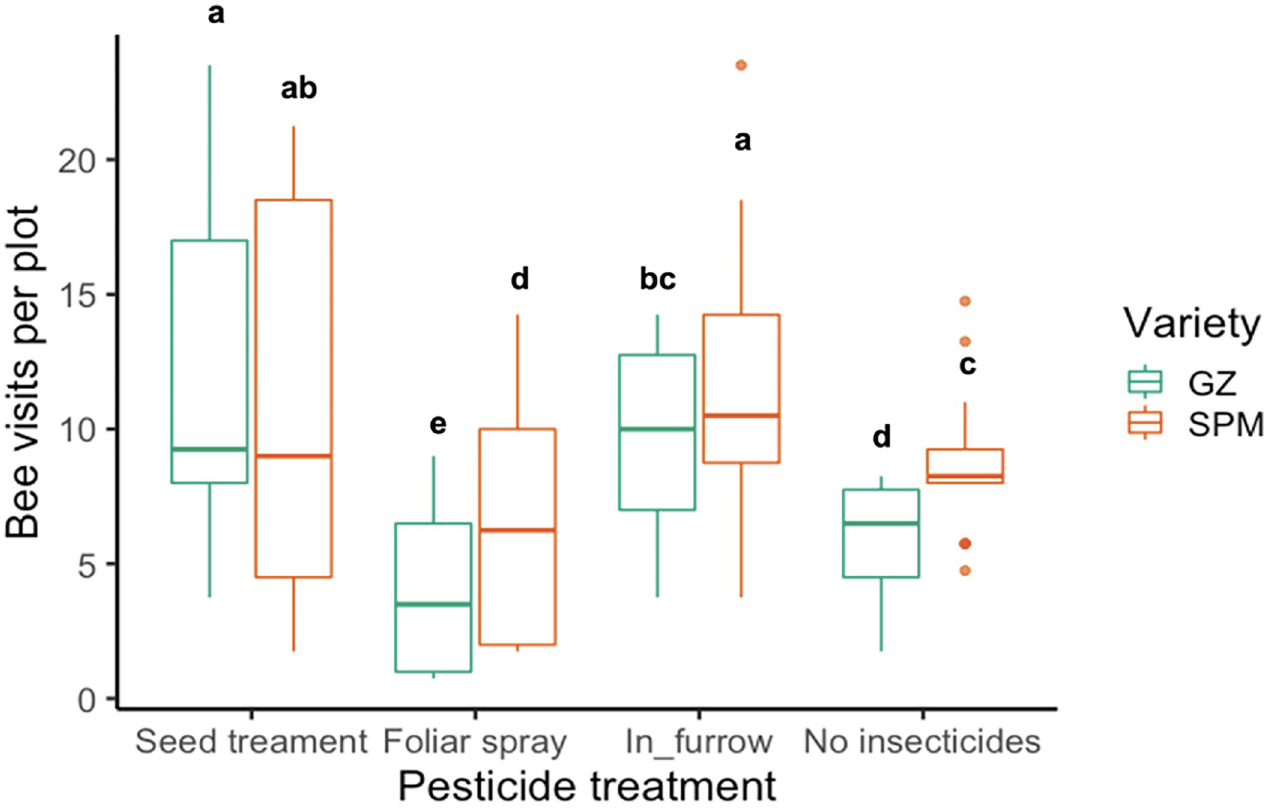
Fig 4. Bee visits per plot in two varieties of squash crops (GZ: Golden Zucchini and SPM: Success PM) treated with different thiamethoxam application methods. Whiskers indicate the range of bee visits counted, excluding outliers. Upper, middle, and lower quartiles indicate the greatest, average, and lowest number of bee visits, respectively. Different letters indicate significant differences between levels of the treatment based on Tukey’s HSD post-hoc test (p < 0.05).